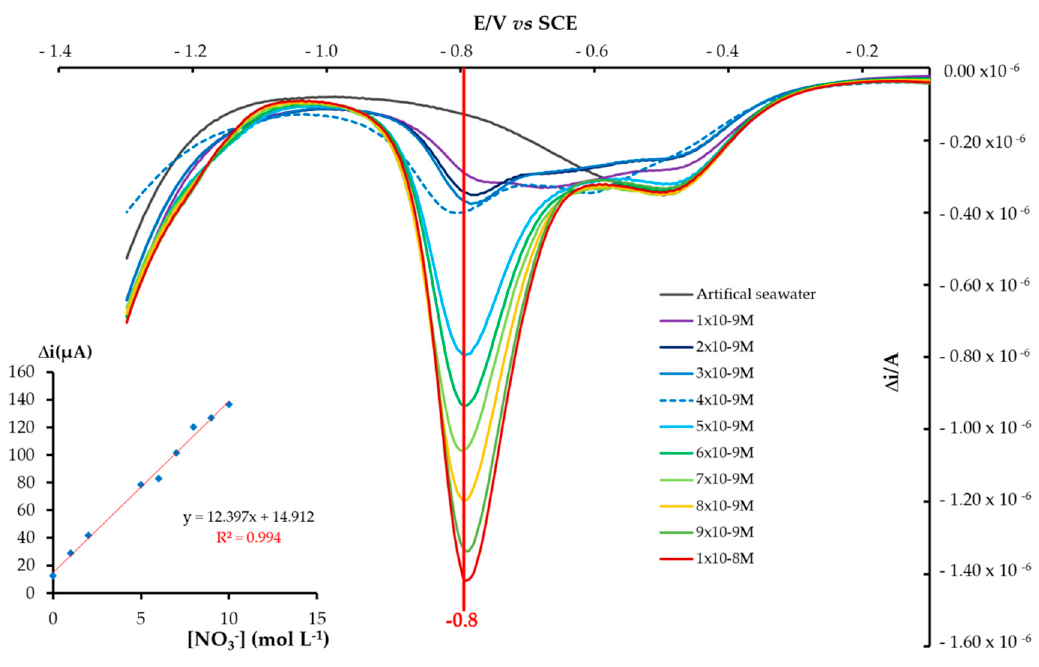
Figure 4. Square wave voltammograms obtained in aerated artificial seawater for succesive nirate ions concentrations on the gold electrode functionalized by in situ metalorganic deposition of silver nanoparticles (E Au/AgNPs ). Inset: Calibration plot based on the peak current ( ∆ i). i vs . [NO 3 − ] and linear regression.